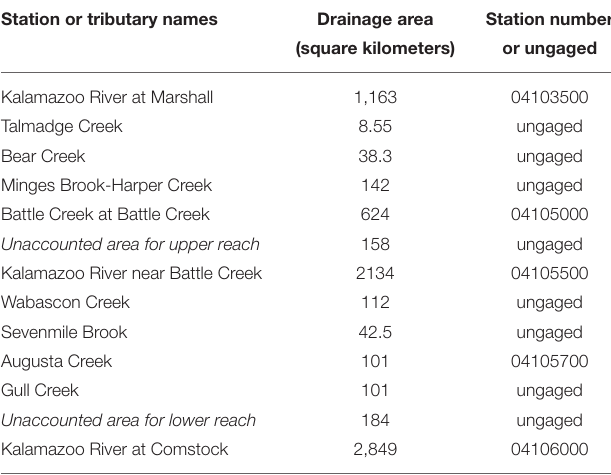
TABLE 1 | Drainage areas of main tributaries and USGS gaging